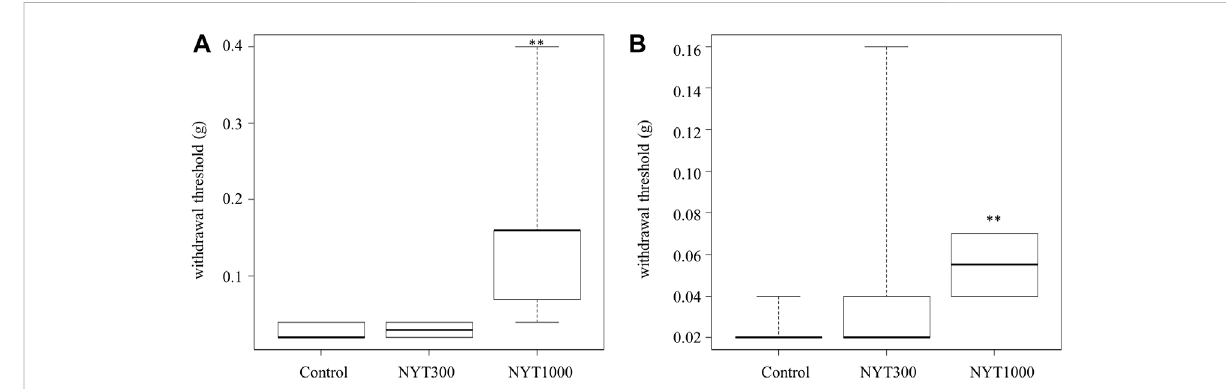
FIGURE 4 Effect of NYT on CIA-induced mechanical allodynia in same score group. (A) Group arthritic score 1 and 2 (Number of legs; Control n = 5, NYT300 n = 4, NYT1000 n = 10). (B) Group arthritic score 3 and 4 (Number of legs; Control n = 9, NYT300 n = 10, NYT1000 n = 4). Values are expressed as median Please clarify. pp p < 0.01 vs. Control group by Steel test.